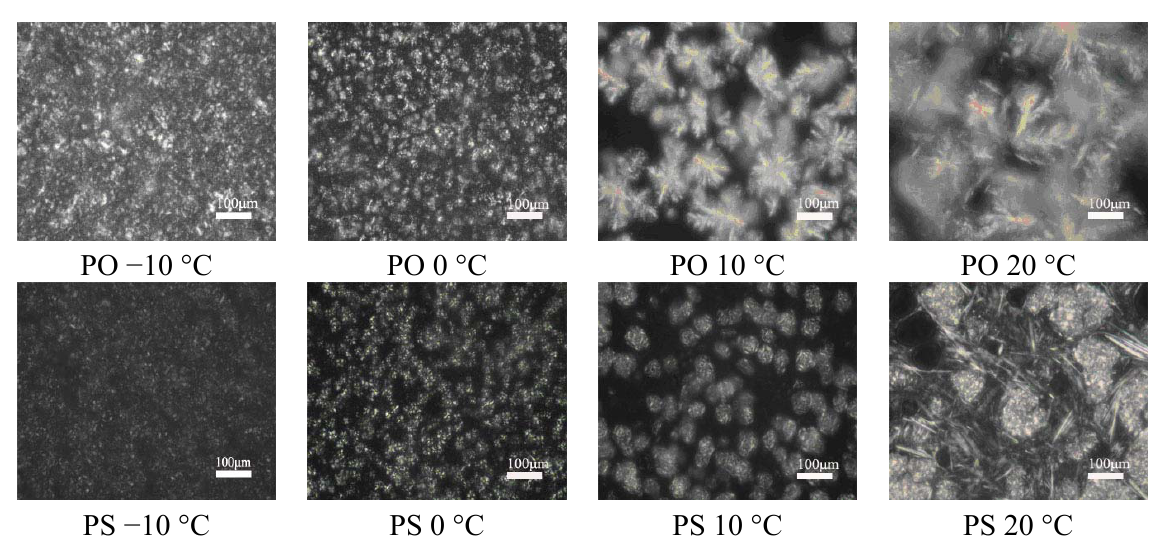
Figure 7. PLM images (×100) of PS and PO at − 10 °C, 0 °C, 10 °C, 20